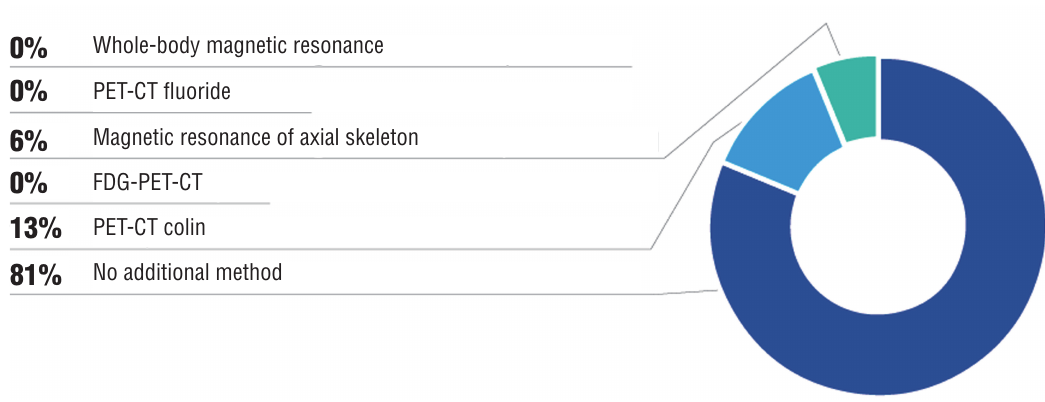
figure 3 - In patients with biochemical progression and negative scintigraphy and computorized tomography, which other diagnostic method should be